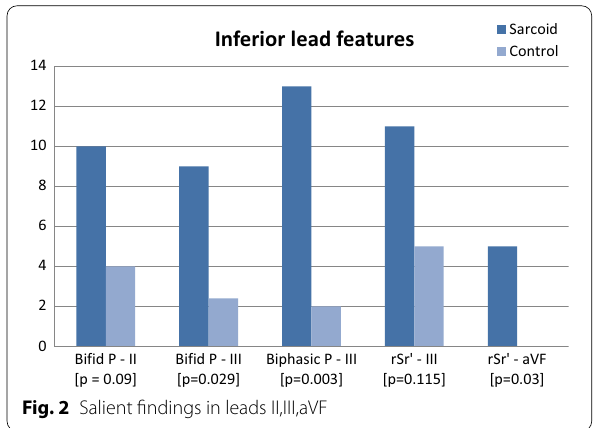
Fig. 2 Salient findings in leads